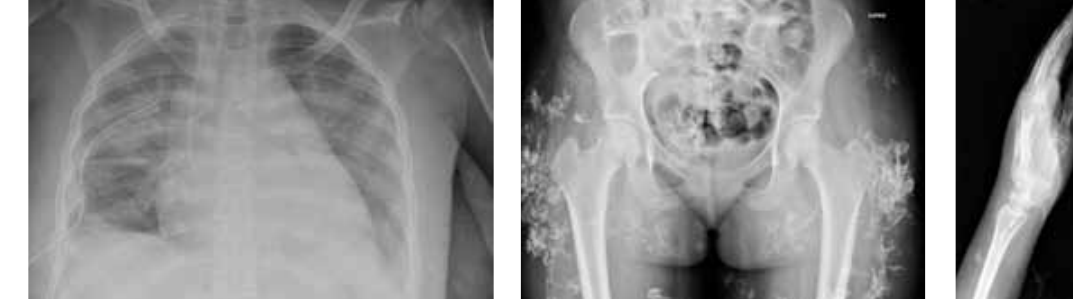
Fig. 2b. Lateral radiograph of the hands including the wrists demonstrates soft- tissue calcifications of the